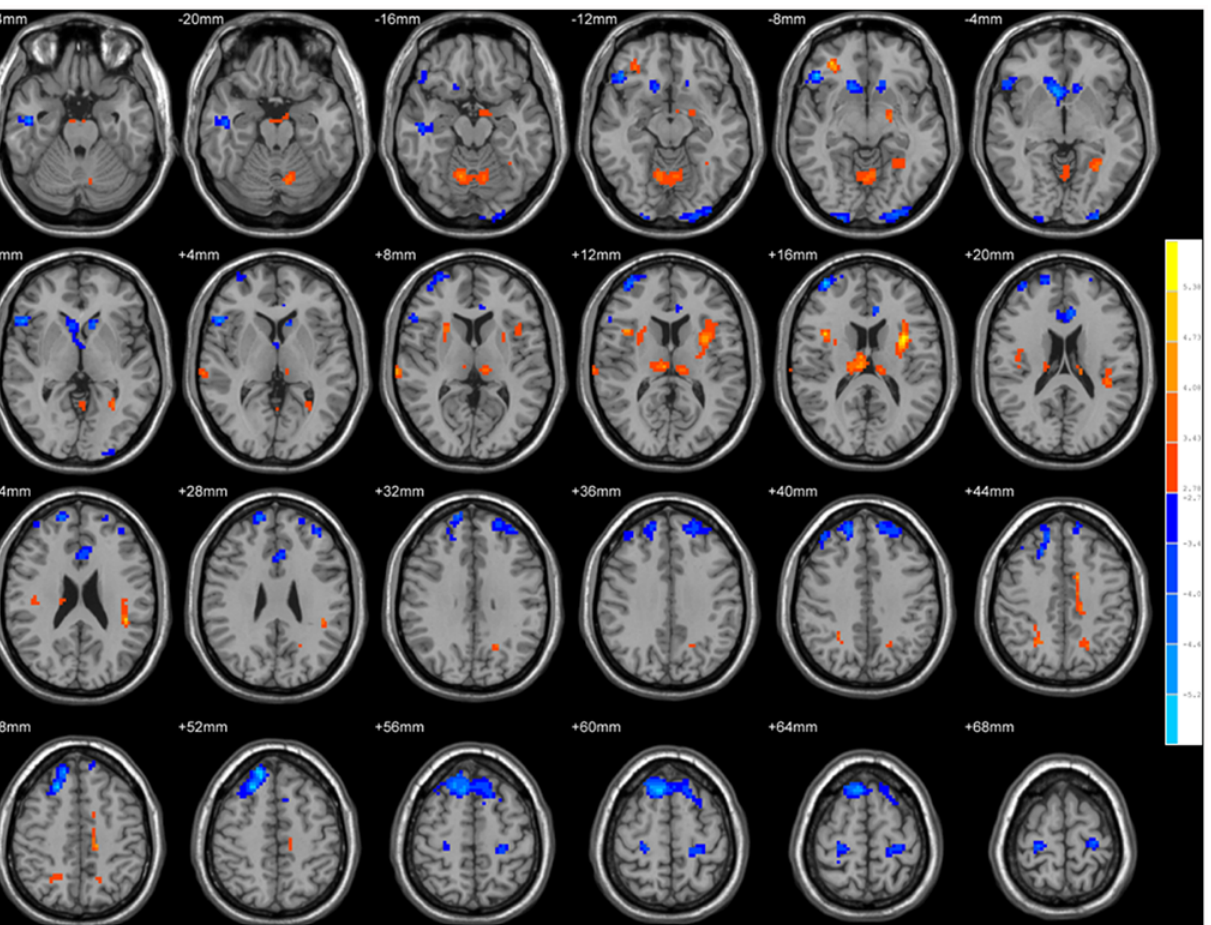
Fig 2. Brain areas with altered ReHo compared with healthy controls (Alphasim corrected, p alpha < 0.05). The blue areas showed decreased ReHo in acute SCI patients relative to healthy controls. The regions are the bilateral primary motor cortex/primary somatosensory cortex, bilateral supplementary motor area/ dorsal lateral prefrontal cortex, right inferior frontal gyrus, bilateral dorsal anterior cingulate cortex and bilateral caudate. The red areas showed increased ReHo in acute SCI patients. The regions include bilateral precuneus, the left inferior parietal lobe, the left brainstem/hippocampus, the left cingulate motor area, bilateral insula, bilateral thalamus and bilateral cerebellum. The left side of the image corresponds to the right hemisphere of the brain. The underlying structure image is Ch2 image.